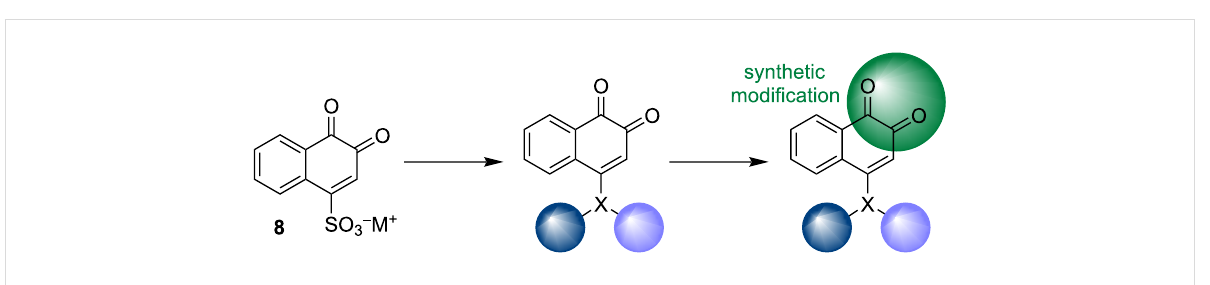
Figure 4: Modifications that can be easily carried out from the products of β -NQS 8 .